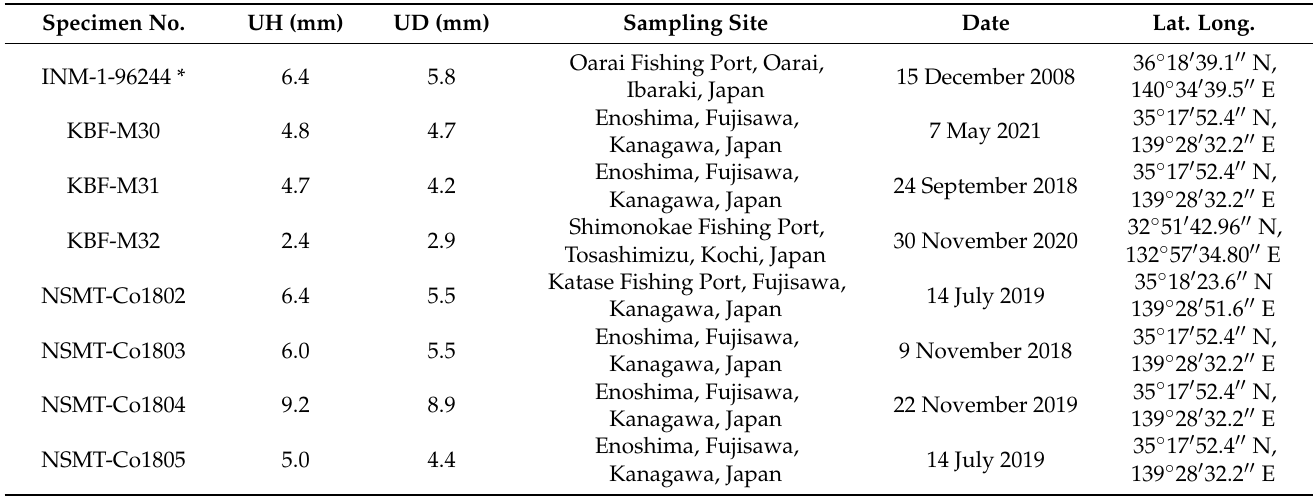
Table 3. Morphometrics (mm) of Octorhopalona saltatrix . * The holotype. Nos. KBF-M30-32 and NSMT-Co1802-1805 are paratypes. UH, umbrella height; UD, umbrella diameter. Specimen